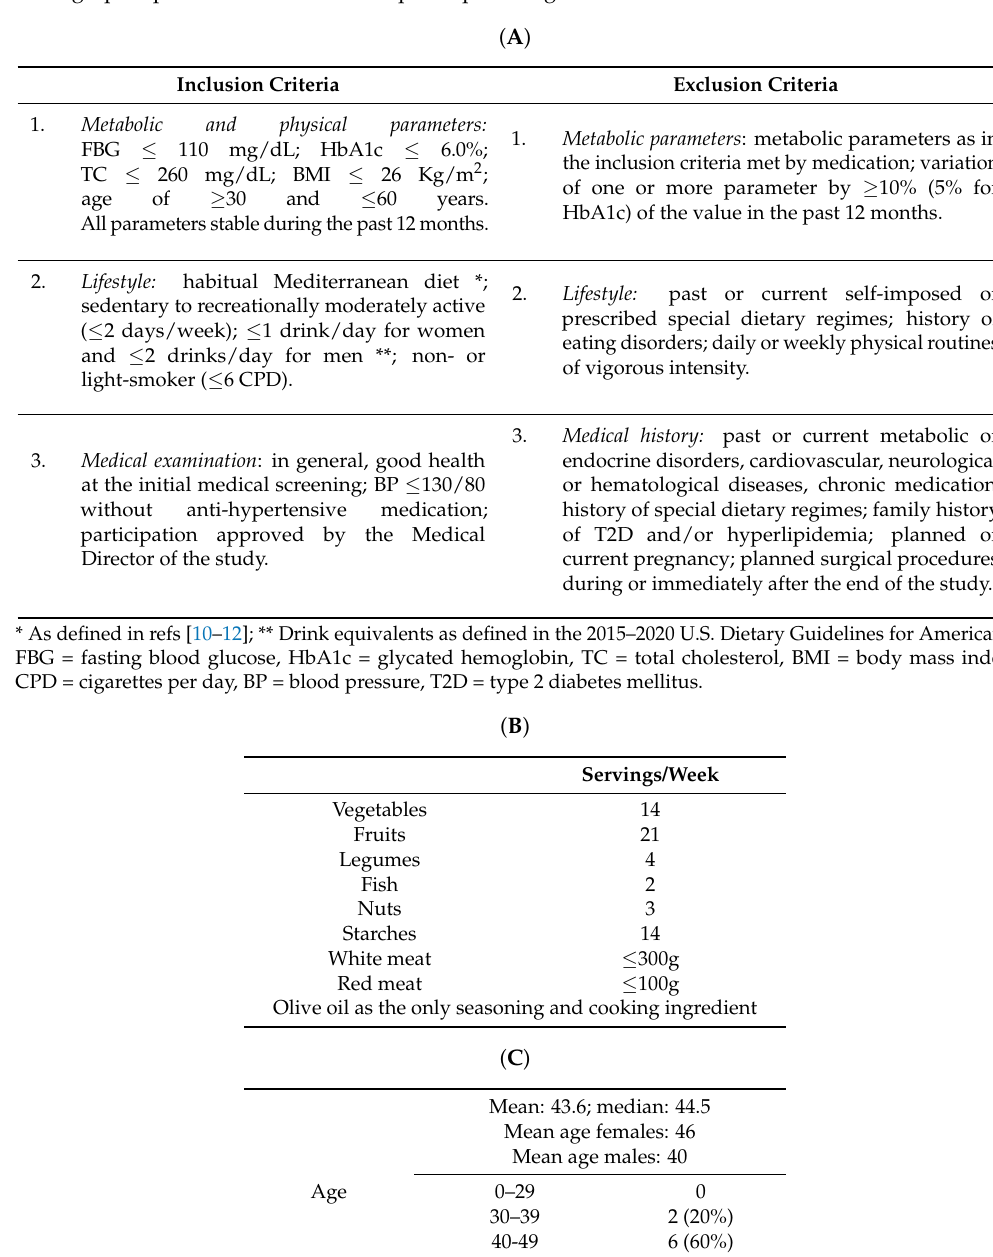
Table 1. Inclusion and exclusion criteria of the clinical study. ( A ) General inclusion and exclusion criteria. ( B ) Composition of the Mediterranean diet exemplified during candidate selection. ( C ) A brief demographic profile of the 10 selected participants is given